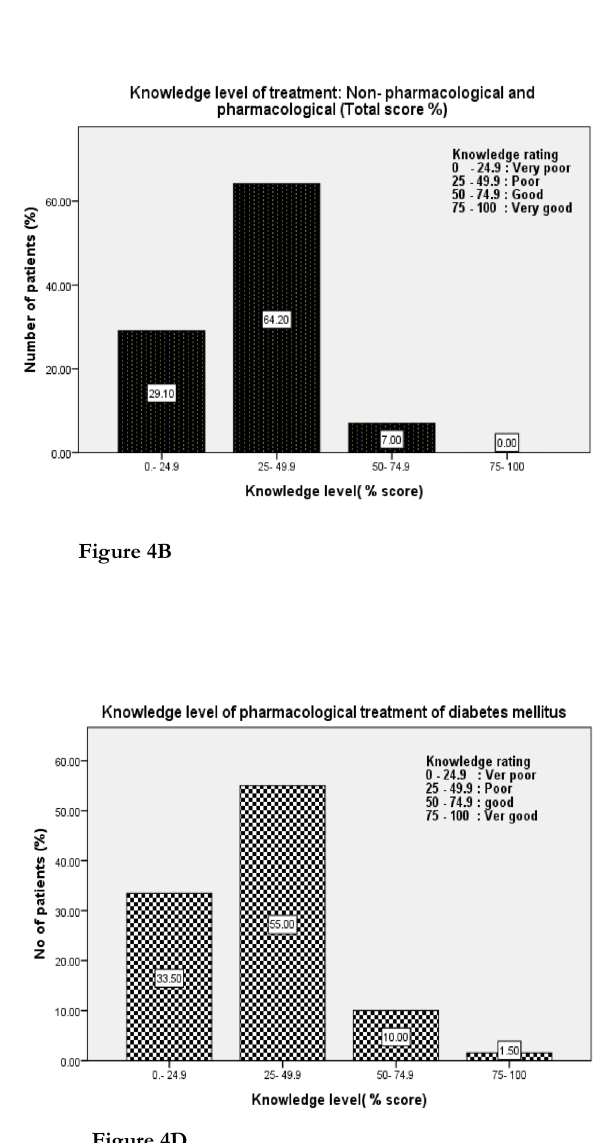
Figure 4: Knowledge levels of diabetes mellitus based on diagnosis, treatment, complications, prevention and prognosis.